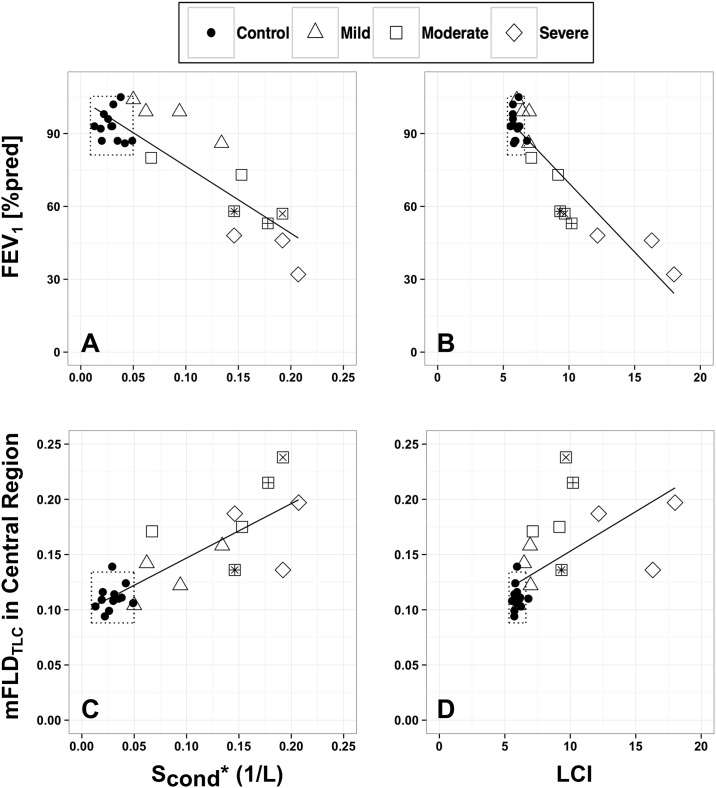
MBW indices (Scond*, LCI) vs. FEV1 [%pred] and the median fractional lung density (mFLD) in the central region (large airways) at total lung capacity (TLC).(A,C) Scond* (1/L) and (B,D) LCI vs. (A,B) FEV1 [%pred] and (B,D) mFLDTLC. Data presented for 12 healthy controls 12 CF adults with stable disease (4 had mild (FEV1 > 80%), 5 had moderate disease (50%<FEV1<80%), and 3 had severe disease (FEV1 < 50%)). Dotted lines are range of values for the control subjects in study (i.e mean ± 1.96*SD). Individual subjects with similar FEV1 [%pred] and LCI 2% are identified by +, * and ×.